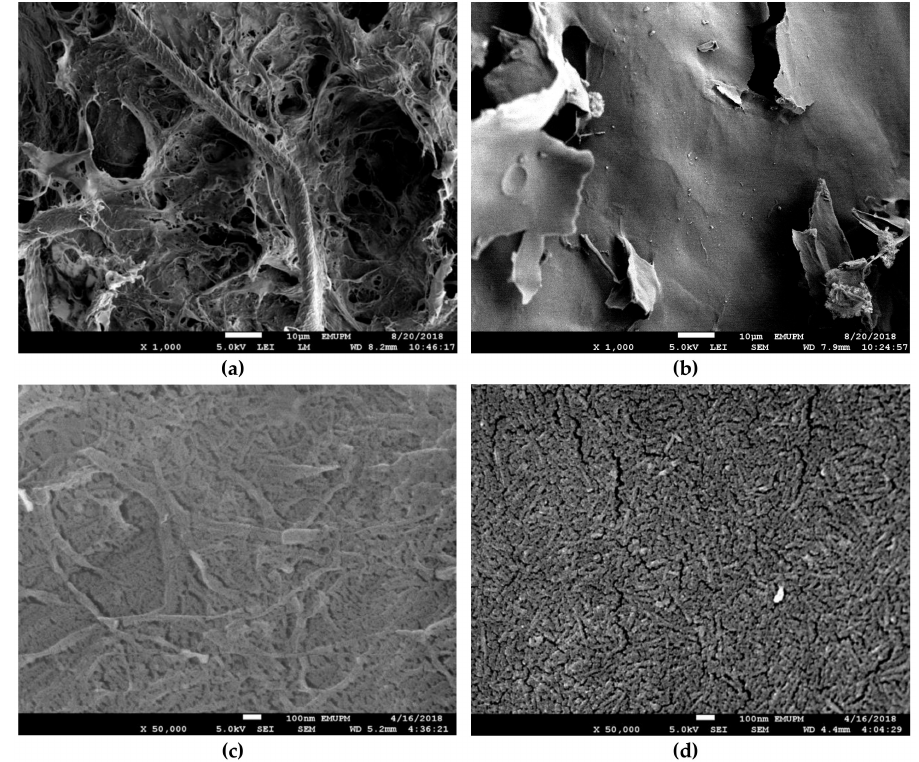
Figure 2. Field emission scanning electron microscope (FESEM) micrograph of 2 wt% freeze dried ( a ) CNF at 5000 magnification, ( b ) CNC at 5000 magnification, ( c ) CNF at 50,000 magnification, and ( d ) CNC at 50,000